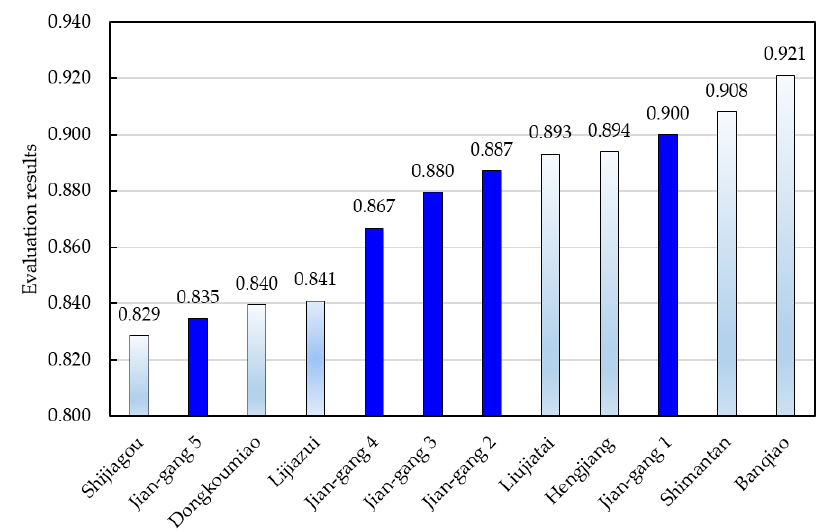
Figure 4. Evaluation results of dam breach of Jiangang Reservoir and some validation reservoirs.